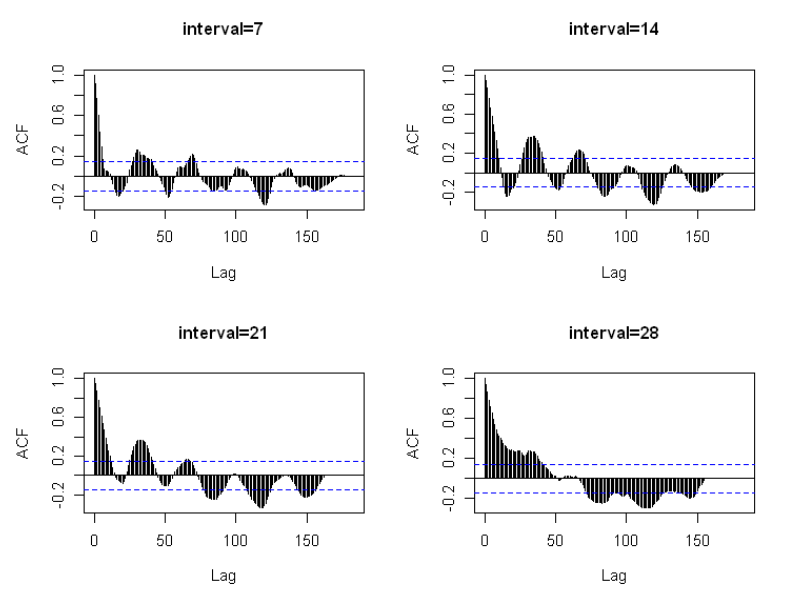
Figure 7. Autocorrelation (ACF) plot of interval length 7, 14, 21 and 28 in Group